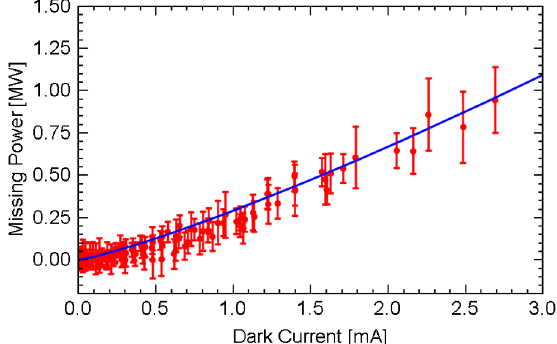
FIG. 4. Q 0 at the end of the rf pulse, when it reaches a minimum, versus calculated gradient for different rf pulse lengths. The plot shows no obvious dependence on pulse length, but a strong dependence on peak surface electric fields.